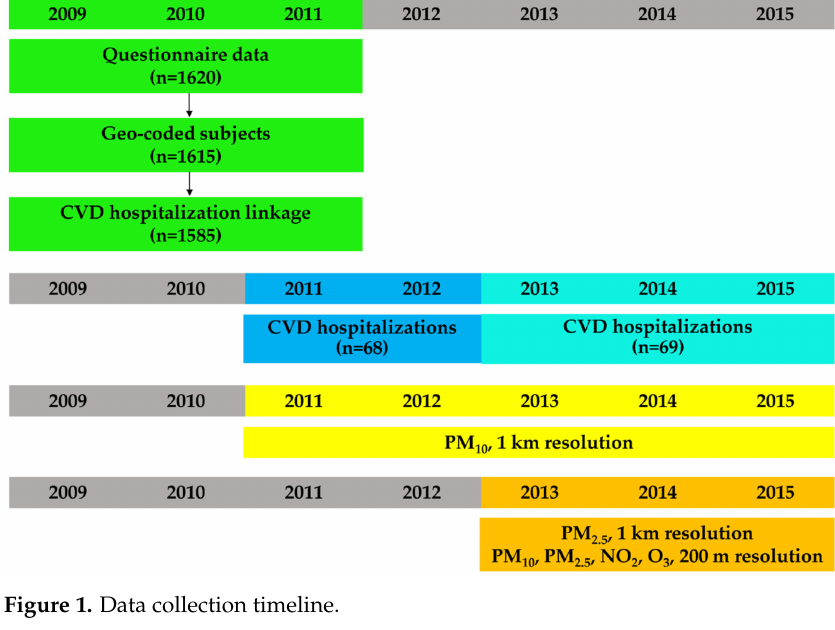
Figure 1. Data collection timeline.